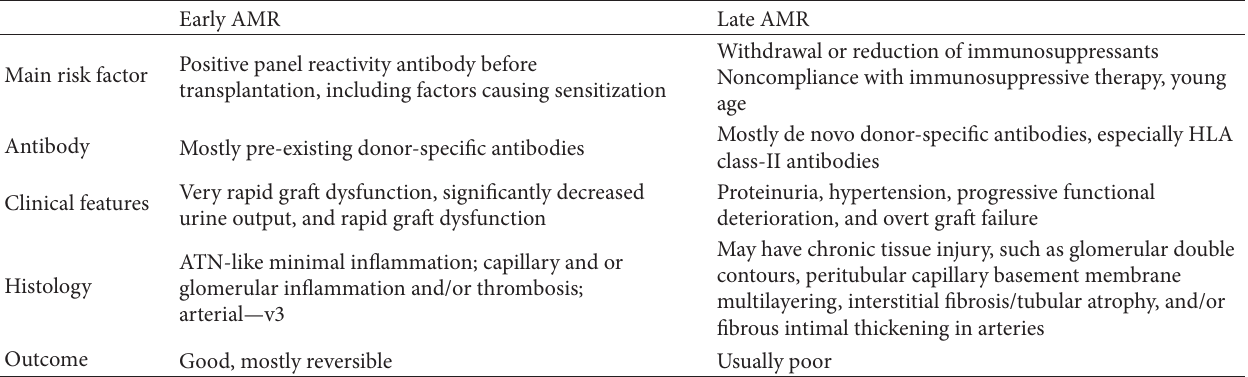
Table 1: Early versus late AMR in renal transplant